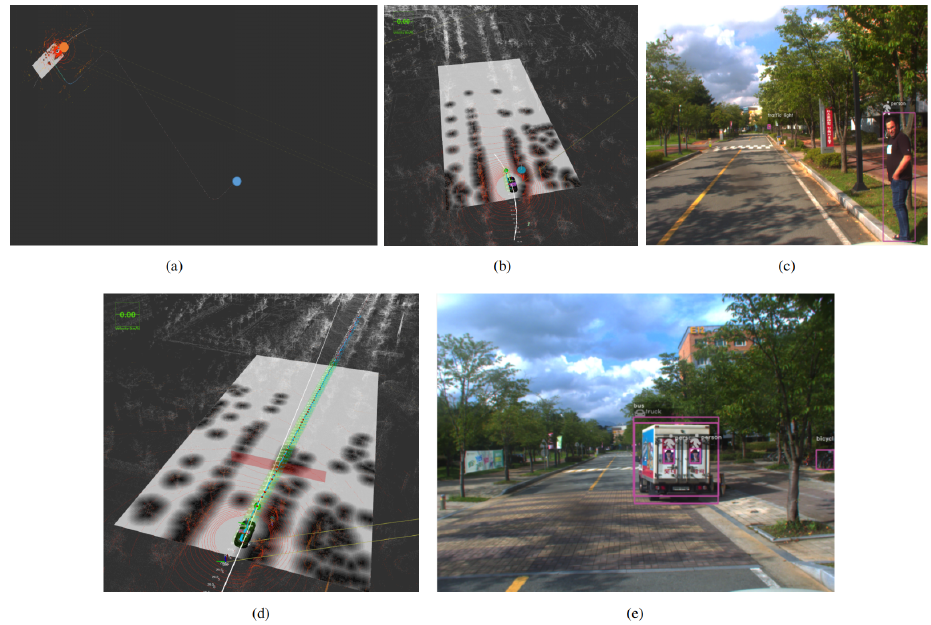
Figure 26. The route of the autonomous vehicle after picking the customer to the destination is illustrated in ( a – c ) along with object detection and autonomous vehicle stopping at the obstacle as shown in ( d , e ). In that particular case, obstacle avoidance is not performed because this is the one-side road and obstructing the yellow line is against the traffic rules (Best viewed in